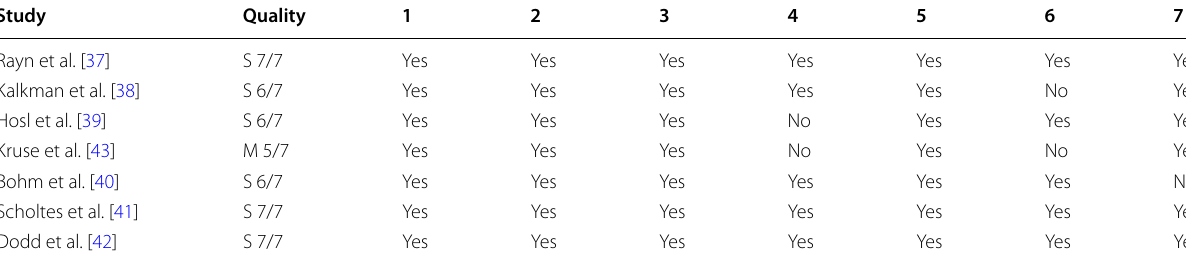
Table 3 AACPDM methodological quality